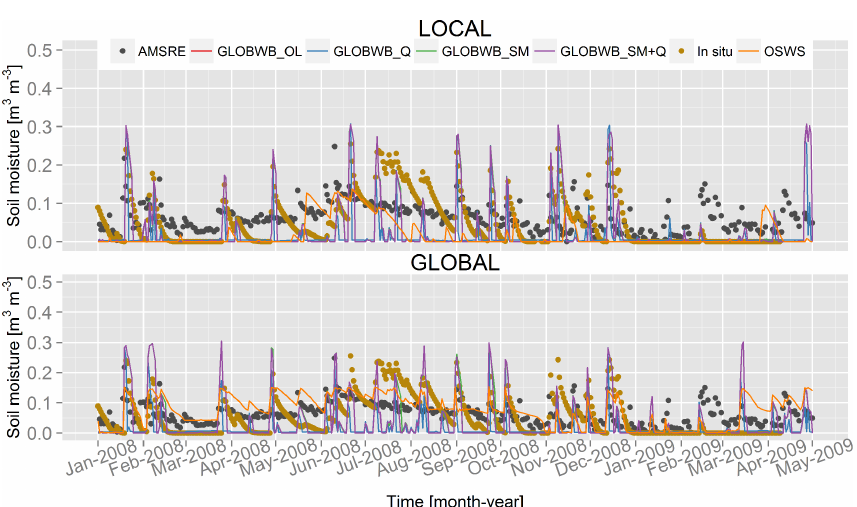
Figure 5. Simulated and observed soil moisture estimates at gauging station no. 410057 in a tributary of the Murrumbidgee River for the time period January 2008–May 2009. The upper panel shows soil moisture time series when local data are used as model forcing. Soil moisture time series obtained with the global forced models are shown in the lower panel. Each panel contains results for each data assimilation scenario plotted with different coloured lines (OSWS – orange, GLOBWB_Q – blue, GLOBWB_SM – green and GLOBWB_SM + Q – purple), downscaled AMSR-E observations with dark grey points and in situ soil moisture observations with dark yellow